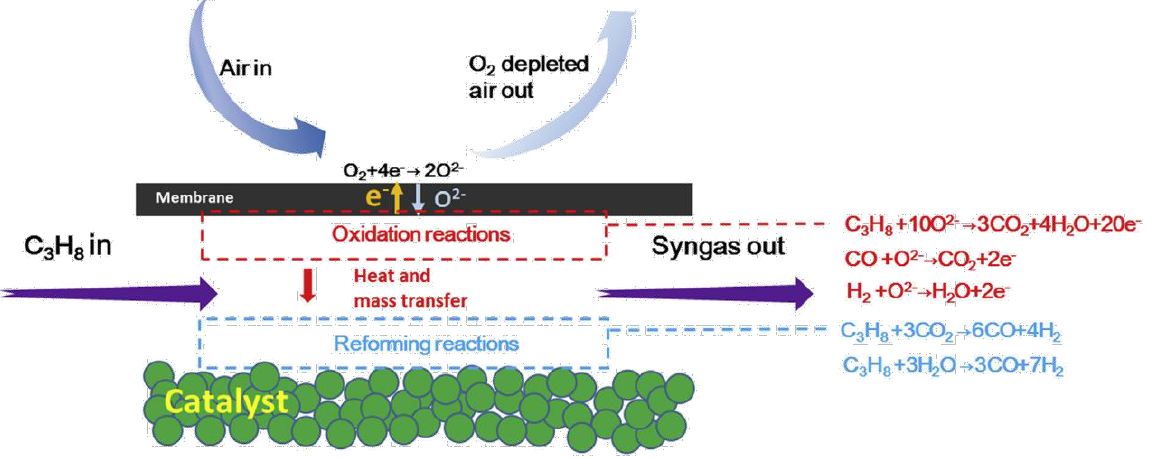
Figure 16. Illustration of POX membrane reactor (Reprinted with permission from Ref. [87]. 2018 Elsevier).